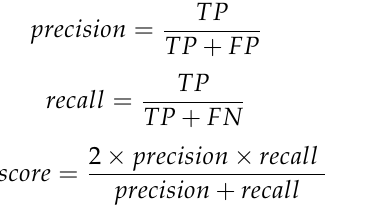
( b ) Figure 6. Anomaly detection by our SSL method for NAB Machine Temperature dataset. ( a ) Anom ‐ aly points with original NAB Machine Temperature dataset; ( b ) anomaly score with threshold.